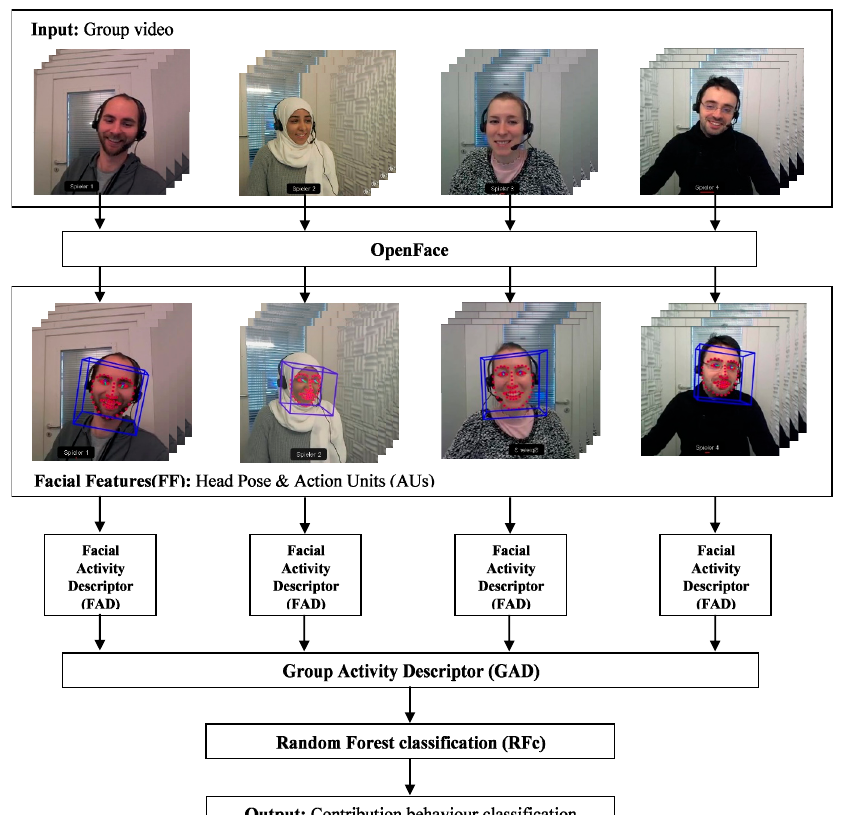
Figure 1. The pipeline of automated facial expression analysis from FFC videos. Each input group video consists of 4 participants communicating for three minutes (in total we have 127 different groups). Each face is first analysed using OpenFace. OpenFace detects the face, facial landmarks, head pose, and extracts facial action units (AUs). AUs and head pose form the facial features for each participant. From these, also for each participant, we calculate facial activity descriptors (FADs). All FADs from all 4 participants are then combined to form the group activity descriptor (GAD). Finally, random forest (RFc) is used to classify the facial contribution behaviour (predicting whether the group will contribute fully or not). Table 1. List of extracted facial features in OpenFace (I—intensity, P—presence).